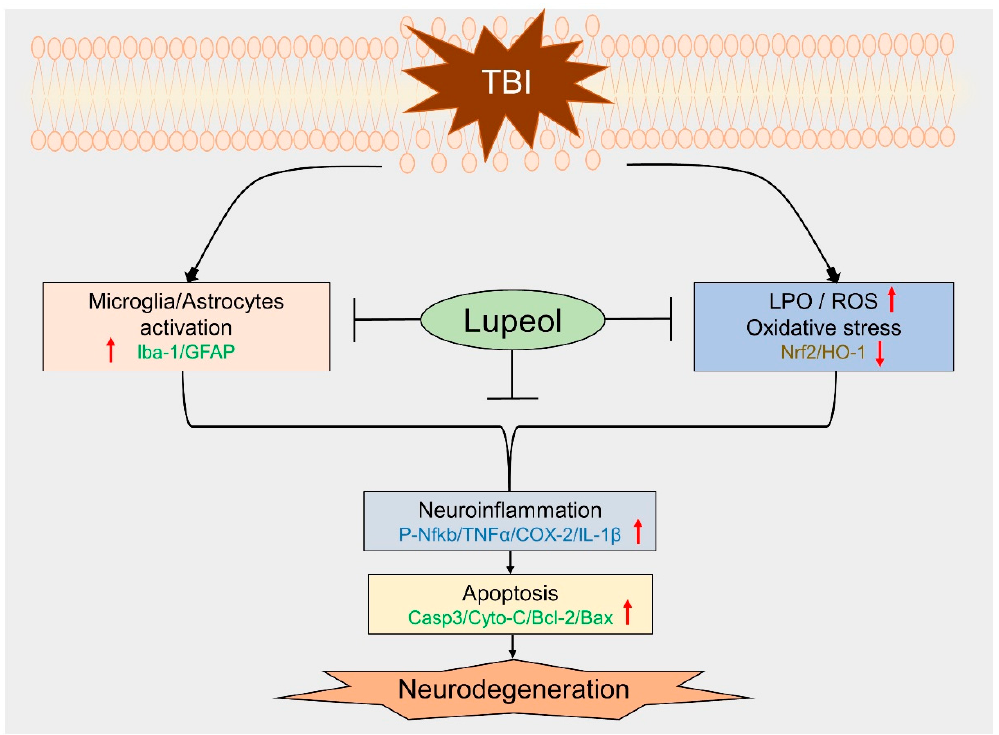
Figure 6. Suggested graphical representation of possible Lupeol neuroprotective effect against TBI- induced neurotoxicity. Lupeol (a triterpenoid) reduced TBI-induced neuroinflammation, oxidative stress, neuroapoptosis, memory impairment, and neurodegeneration induced by TBI in mouse brain. (Upward direction of arrow indicates activation/upregulation, while downward direction indicates downregulation).